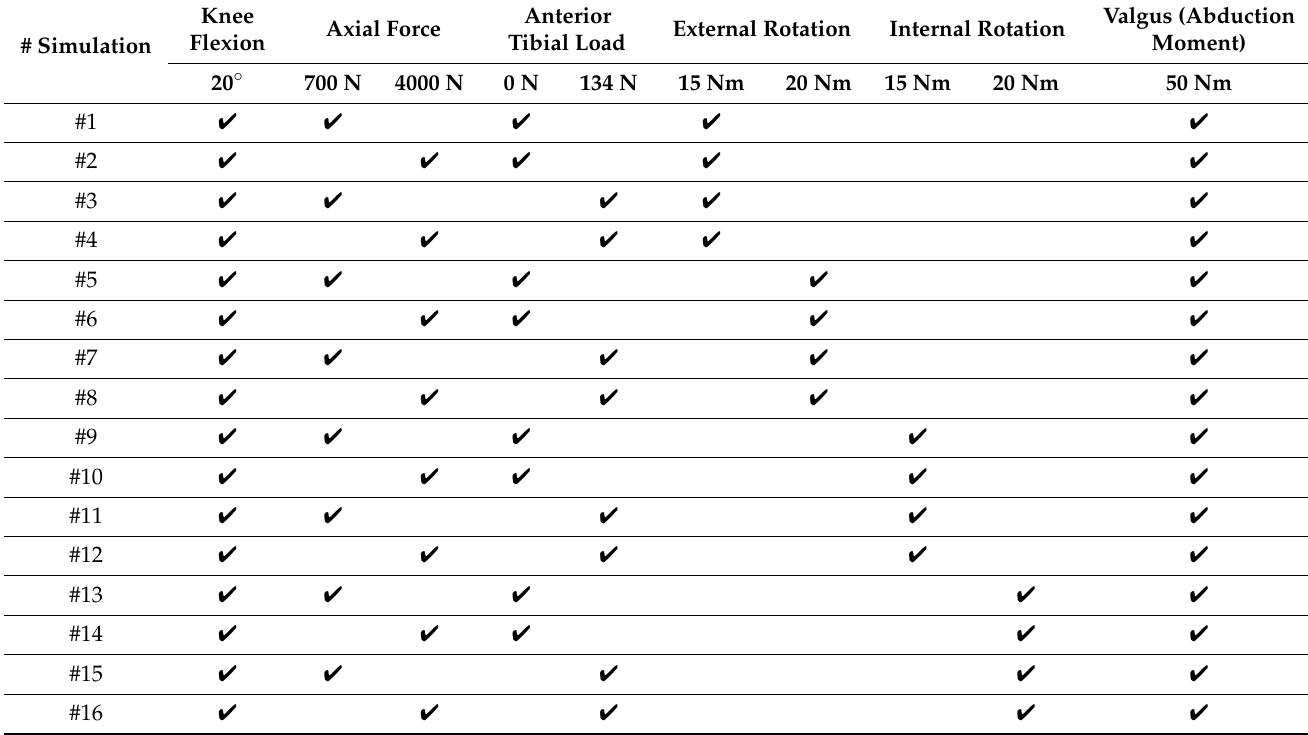
Table 2. Simulations performed with the FEM